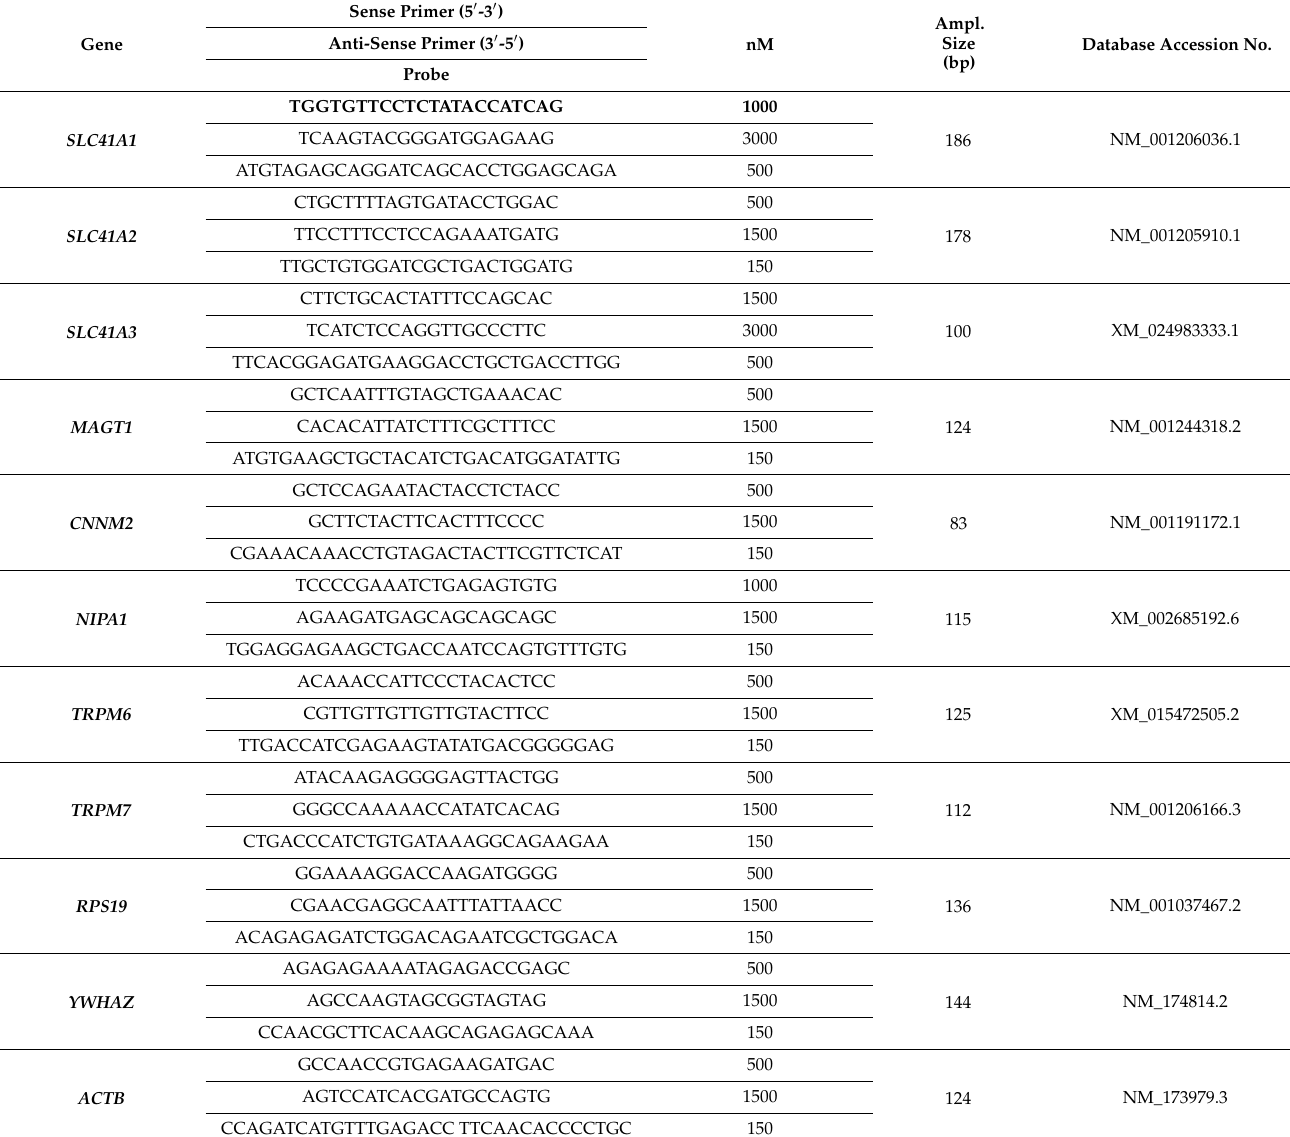
Table 2. Primer and probe sequences, applied concentrations (nM), as well as expected amplicon sizes (bp) and database accession numbers of magnesium-responsive genes and reference